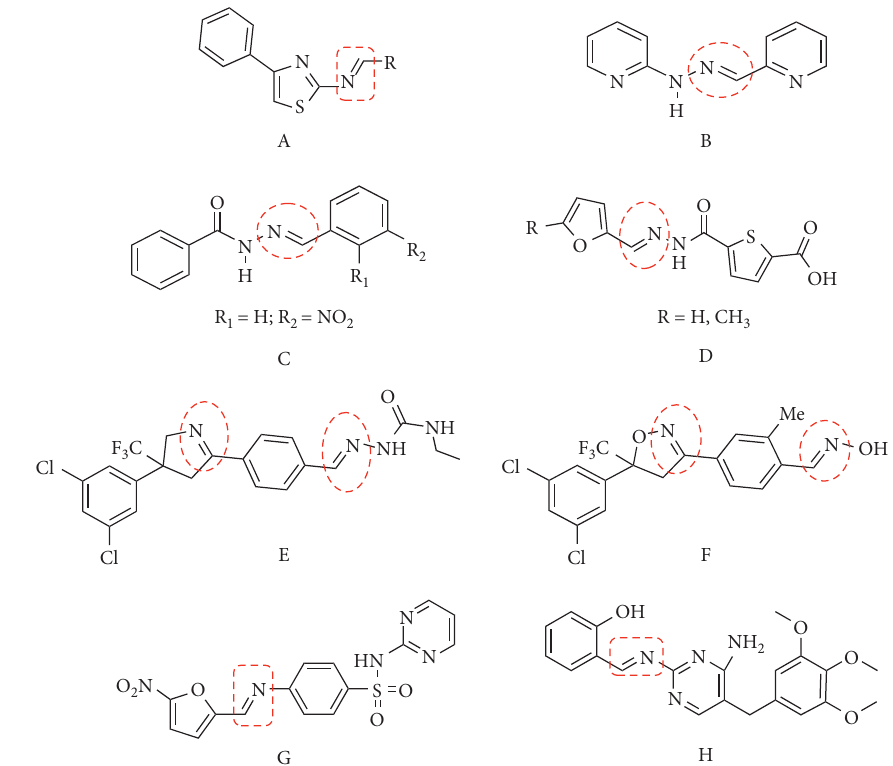
Figure 1: Various biologically active Schiff bases.